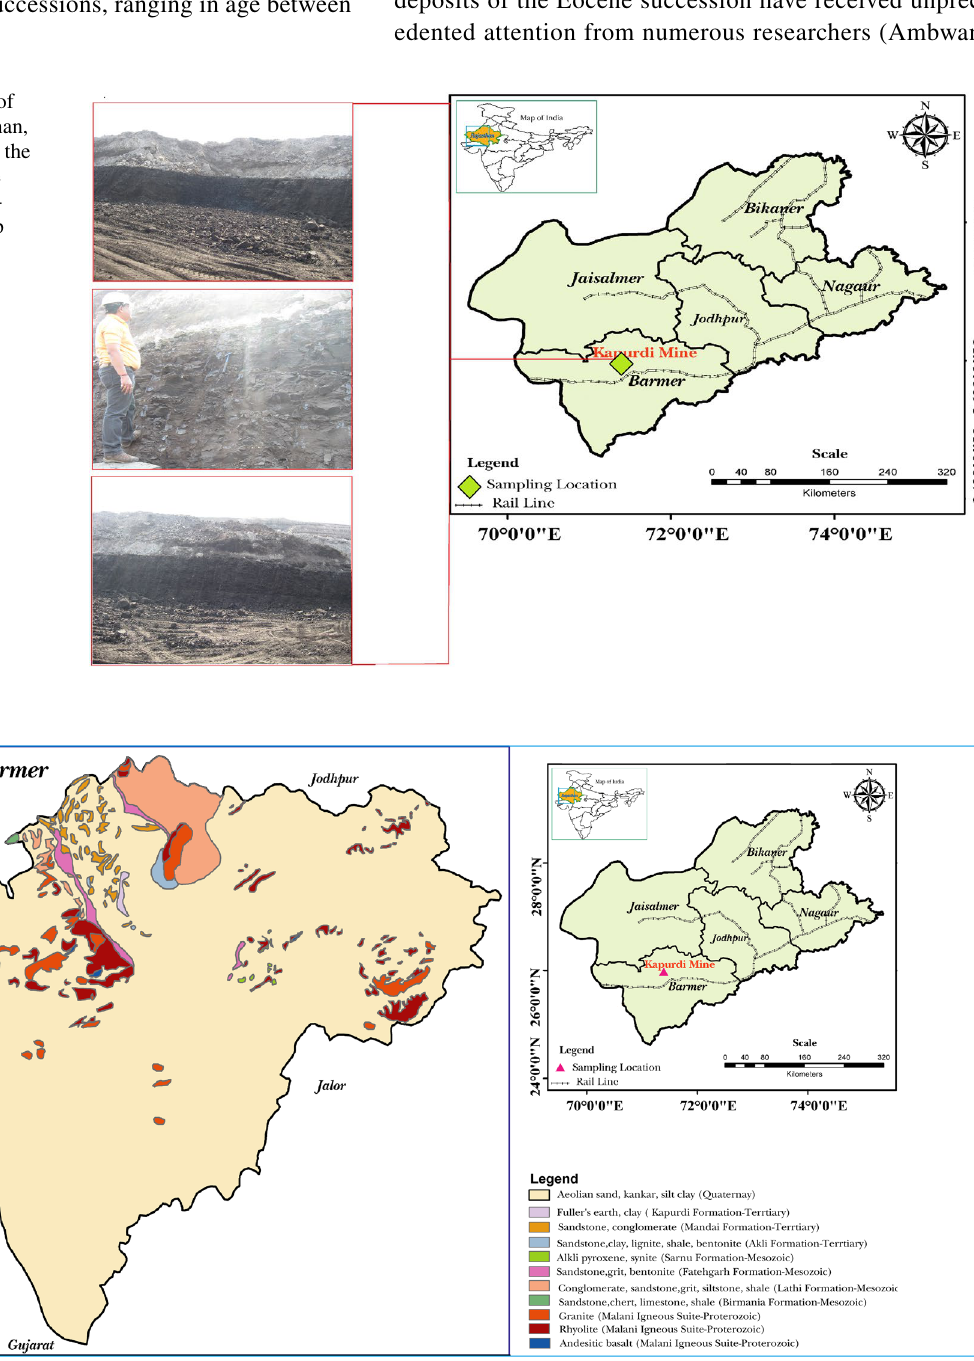
Fig. 2 Geological map of the Barmer Basin, including igneous rocks and sedimentary